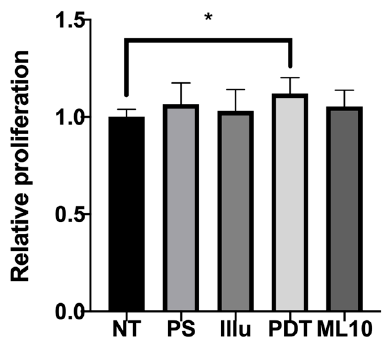
Figure 6. Proliferation assay of activated human PBMC culture with conditioned media of five